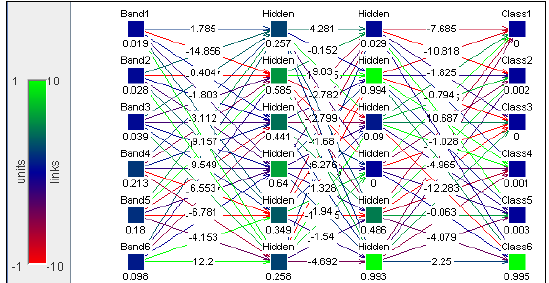
Figure 5. Multilayered Neural Network. Units on the left side are input units (spectral bands); units in the centre are hidden